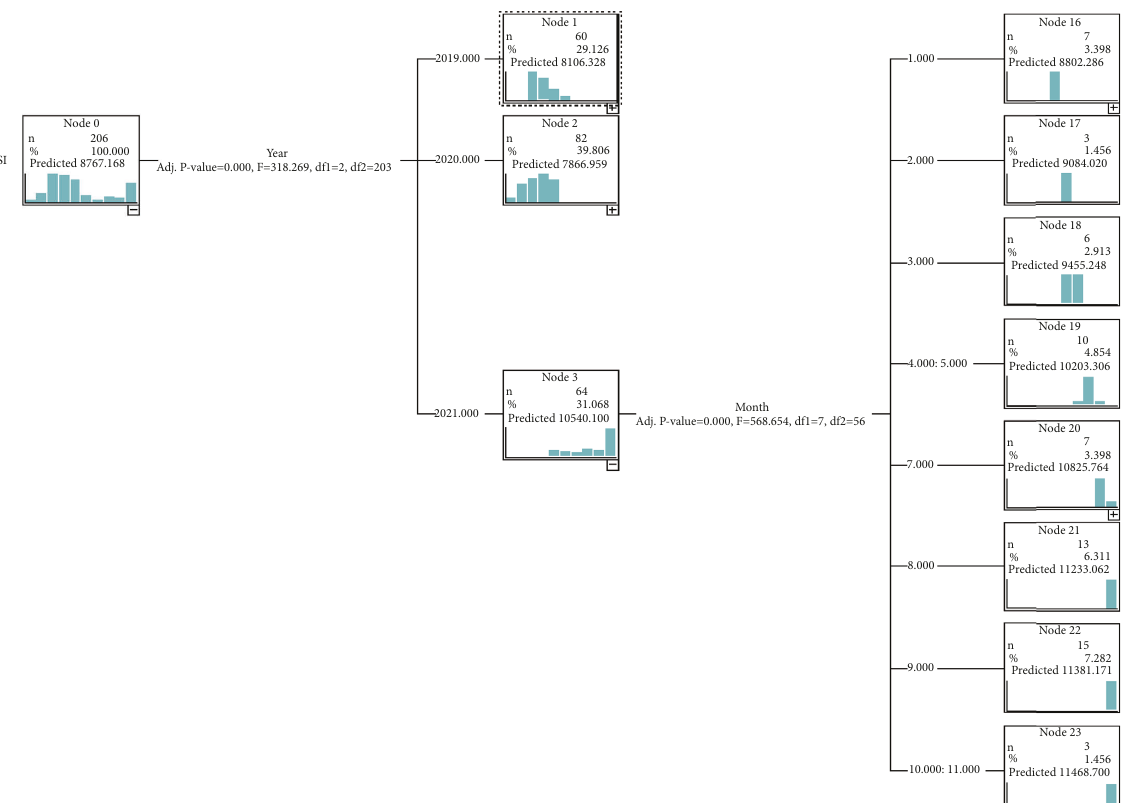
Figure 7: Partial classification tree for TASI CHAID